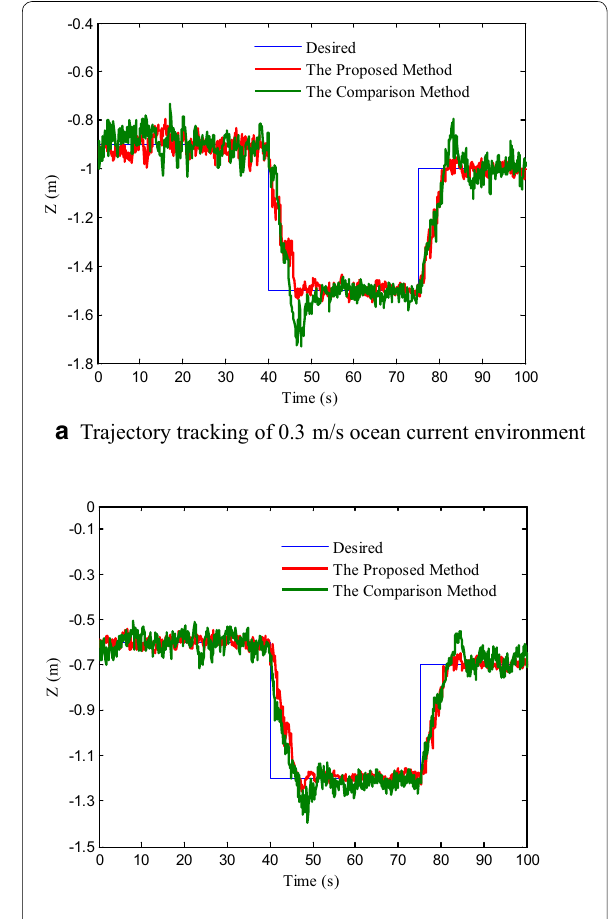
b Trajectory tracking of 0.5 m/s ocean current environment Figure 9 Experimental curves in different ocean current